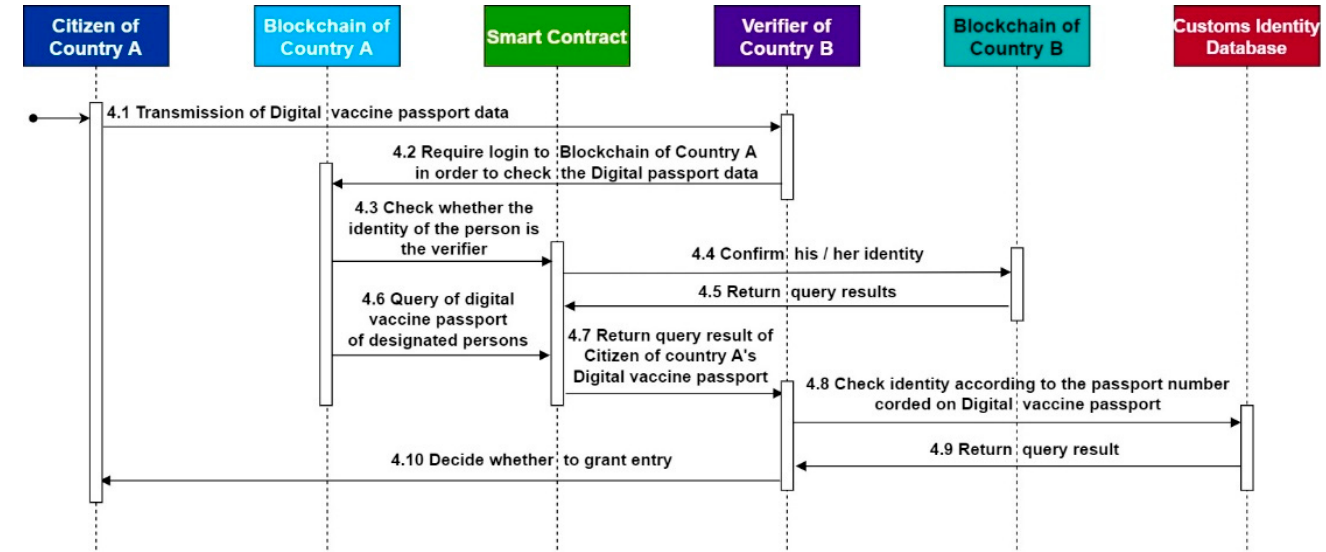
Figure 12. Digital COVID-19 vaccine passport verification sequence diagram.